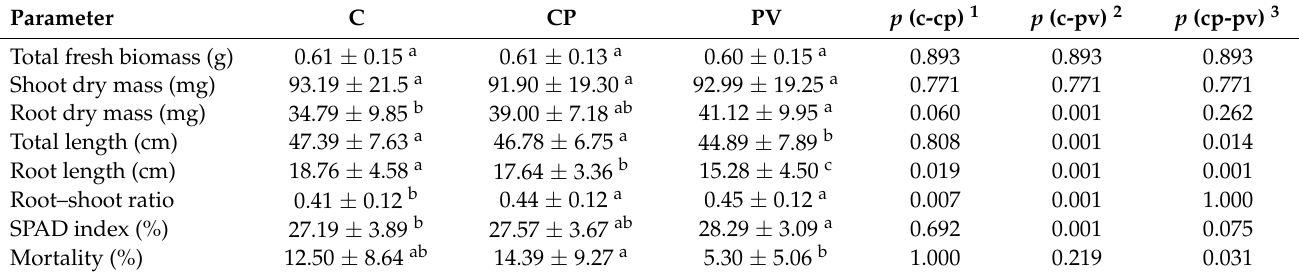
Table 6. Wheatgrass growth indicators in the three different substrate groups without shoot and root fresh mass and shoot length, “C”—100% coconut fibers; “CP”—70% coconut fibers + 30%